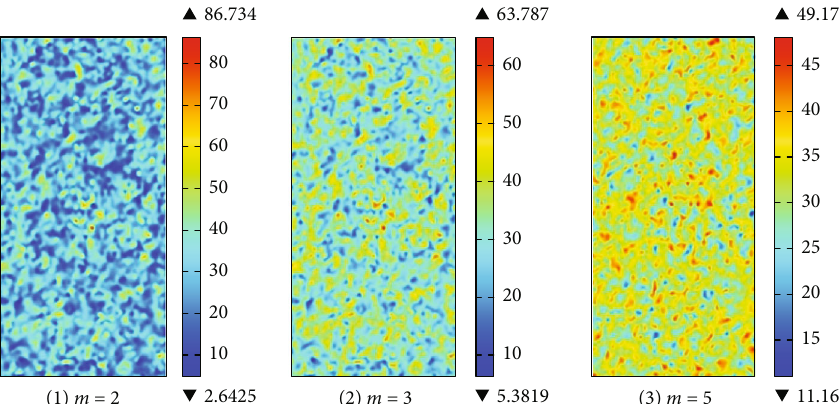
Figure 5: Elastic modulus distribution of microelement of rock mass with di ff erent